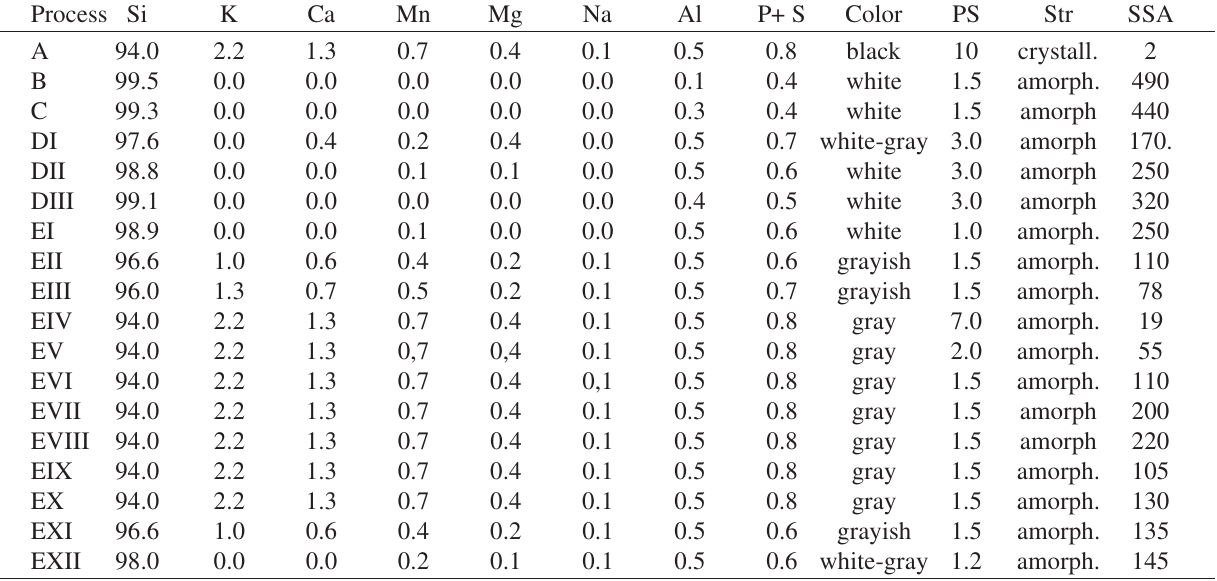
Table 2 . Chemical analysis, wt%, and physical properties of the silica prepared by the A, B, C, D and E processes. Process